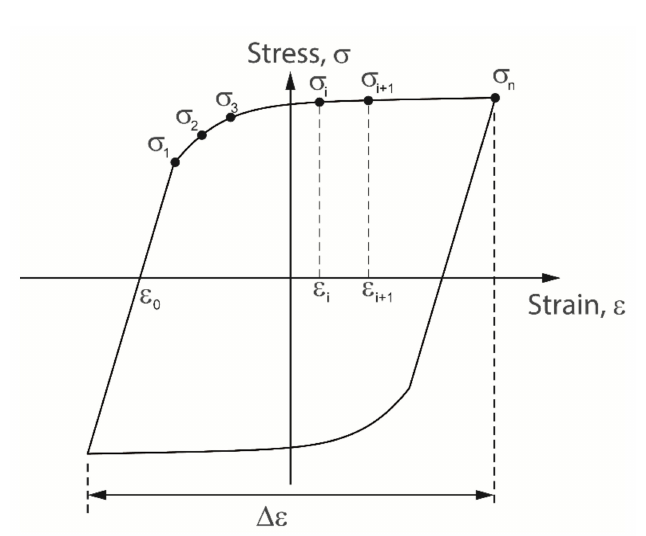
Figure 4. A schematic of a stabilized cycle. (cid:16) (cid:17) α , ε pl Data pairs of extracted from the stabilized stress–strain curve are used to calibrate values of the kinematic hardening parameters C and γ